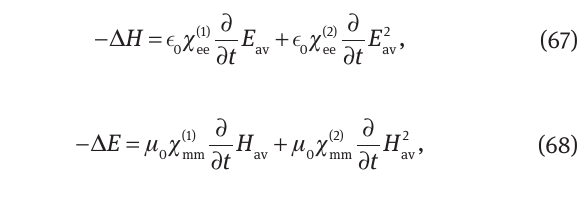
Figure 15: Radiation of a light source (quantum well) embedded in a semiconductor (e.g. GaN) substrate: (A) bare structure; (B) reflec- tionless metasurface, placed on top of the slab, which collimates the dipole fields; (C) introduction of PRMC; and (D) double-meta- surface cavity, with partially reflective top metasurface and fully reflective bottom metasurface.